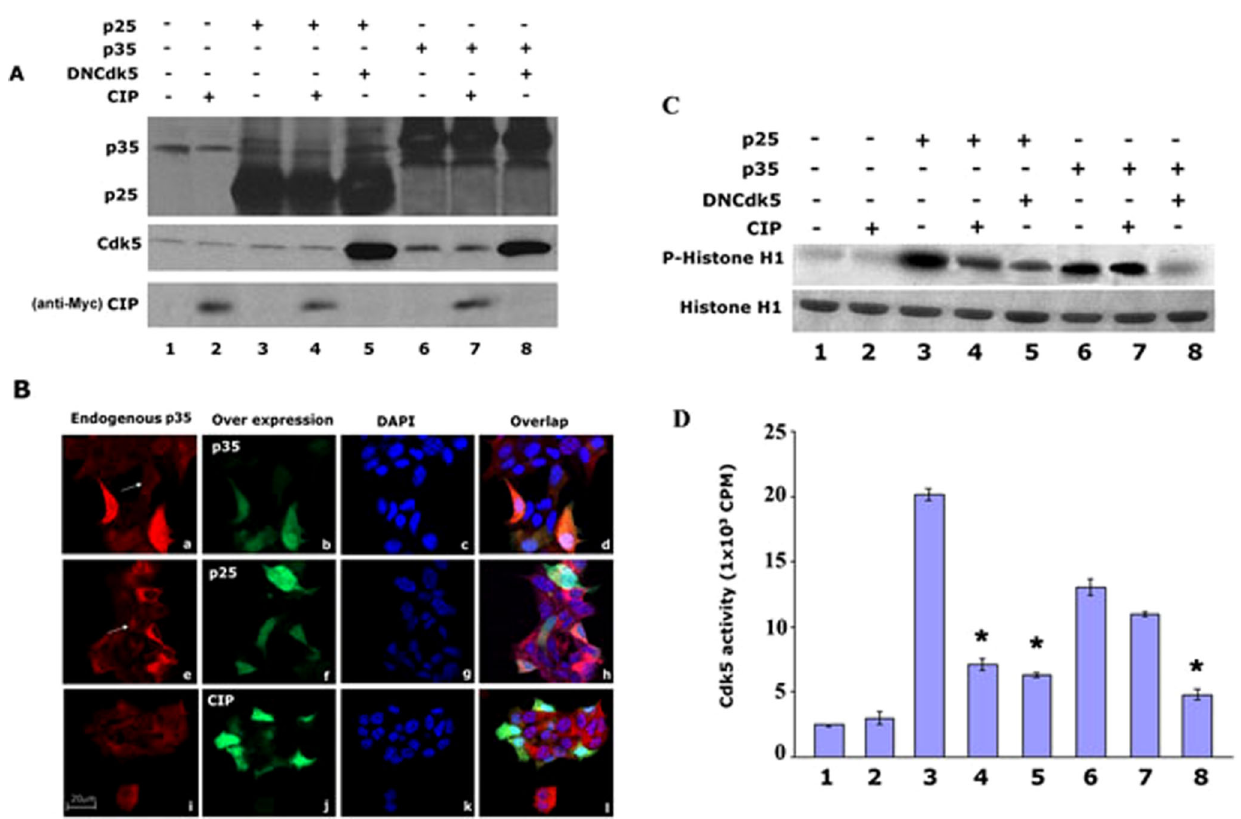
Figure 4. CIP specifically inhibits Cdk5/p25 activity in co- infected Min6 cells. A Expression levels of infected p35, p25, CIP, and DNCdk5 by Western Blot analysis. P35 expressions are in the panel 1, lanes 6–8; P25 expressions are in the panel 1, lanes 3–5; CIP expressions are in the panel 3, lanes 2, 4, and 7; DNCdk5 expressions are in the panel 2, lane 5 and 8. B Confocal images of immunocytochemically treated Min6 cells illustrate the cellular localization of infected p35 (panel 1, a and b), p25 (panel 2, e and f), and CIP (panel 3, j); endogenous p35 (panel 2–4, a, e and i) . The images were obtained using Zeiss LSM 510 laser scanning confocal microscope. C CIP specifically inhibits Cdk5 activity which activated by overexpression of p25 (panel 1, lane 4 compared to lane 3), not p35 (panel 1, lane 6 compared to the lane 7); but DNCdk5 inhibits both (panel 1, lanes 5 and 8). D Activity data quantified (as same as in the autoradiograph), (* P , 0.01). Data represent mean 6 SE of three experiments.